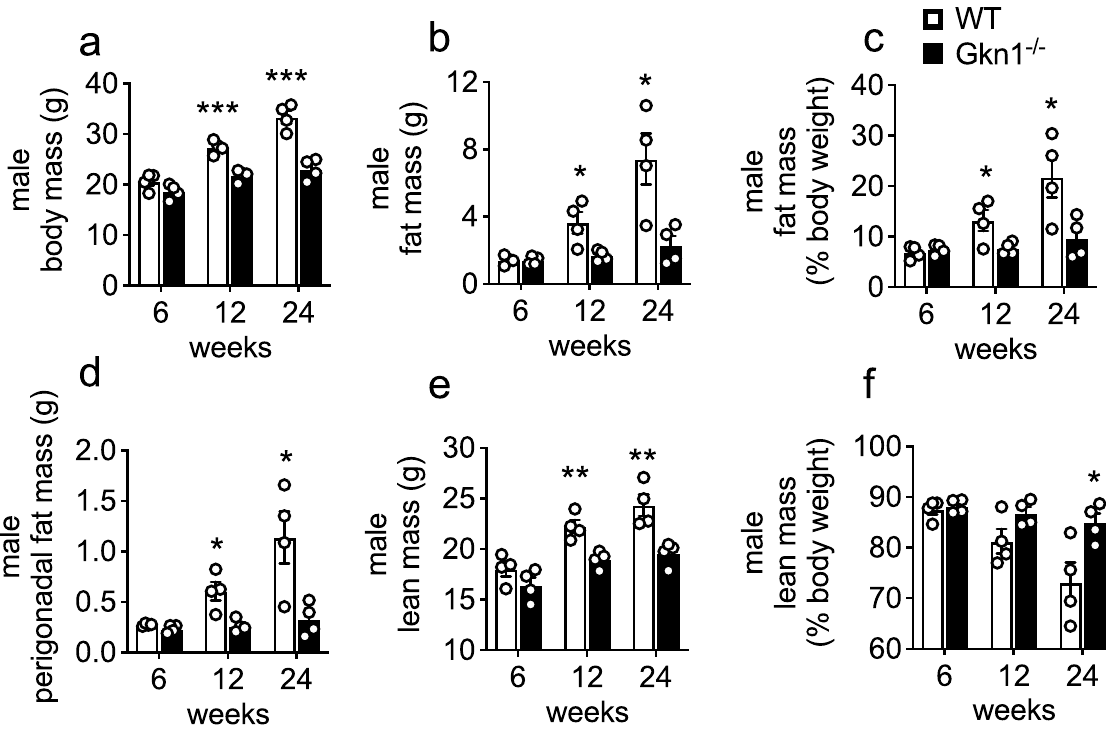
Figure 1. GKN1 regulates age-associated accumulation of body fat. Male WT and GKN1 −/− mice were maintained on NCD ad libitum and assessed at 6, 12 and 24 weeks of age for ( a ) body weight and ( b ) fat mass (by qMRI) or ( c ) fat mass as a percent of body weight. ( d ) Perigonadal fat pads were excised and weighed. (E&F) lean mass was also assessed by qMRI. * p < 0.05, ** p < 0.01, *** p < 0.001 n =